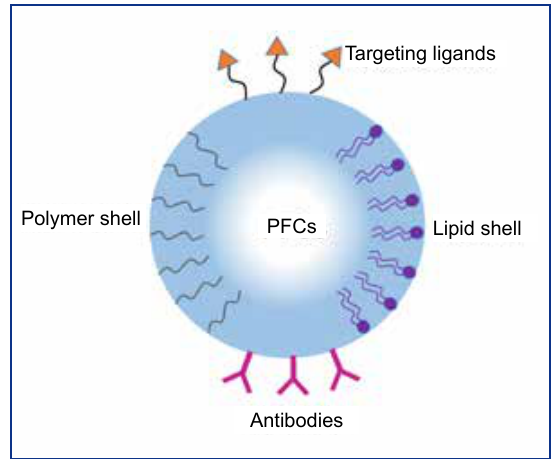
Figure 2 Schematic of the shell compositions, core of PFCs and targeting moiety of ultrasound-responsive